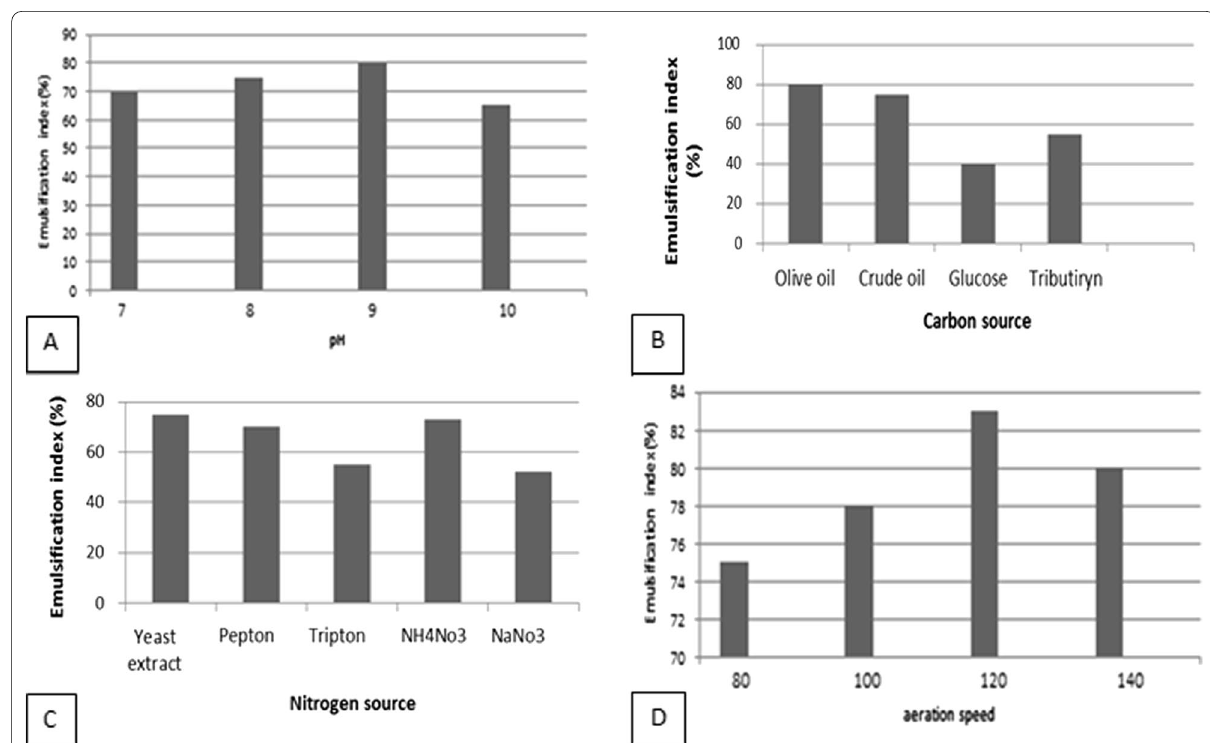
Fig. 3 A Impact of pH in biosurfactant produced by Kocuria rosea ABR6, B impact of carbon sources biosurfactant produced by Kocuria rosea ABR6. C Impact of nitrogen sources biosurfactant produced by Kocuria rosea ABR6. D Impact of agitation biosurfactant produced by Kocuria rosea